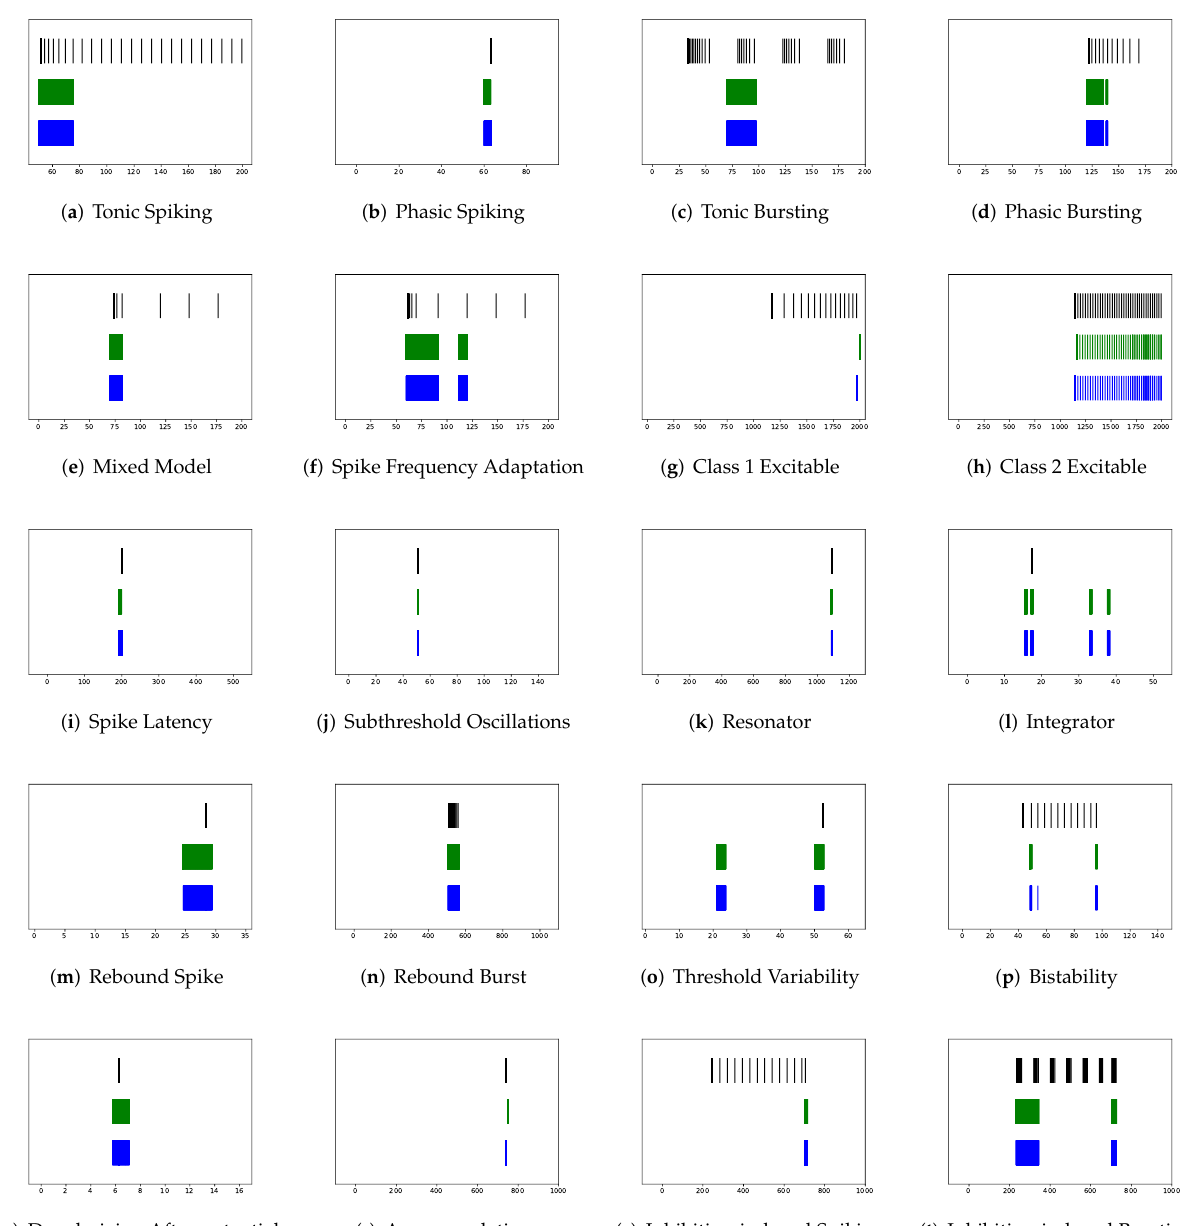
Figure 8. Spike trains of Izhikevich model (black) vs. unmodified RSRM (green) vs. modified RSRM by maximum tolerance (blue), where x-axis is the time (ms). Moreover, Table 2 illustrates that, among all neuron models, RSSRM takes the lowest memory consumption during inference, whereas the Izhikevich model shows the highest memory usage for twenty spiking patterns, excluding (k) resonator, (m) rebound spike, (o) threshold variability and (q) depolarizing after-potential. Compared to SRM, SSRM requires smaller memory for twenty firing behaviors despite a slower inference time. Specif- ically, the memory consumption of SSRM is lower for fifteen firing behaviors (b) phasic spiking, (c) tonic bursting, (e) mixed mode, (f) spike frequency adaptation, (g) class 1 ex- citable, (h) class 2 excitable, (i) spike latency, (k) resonator, (m) rebound spike, (n) rebound burst, (o) threshold variability, (p) bistability, (q) depolarizing after-potential, (r) accommo- dation, and (t) inhibition-induced bursting, while SSRM has only one faster inference time than SRM for (b) phasic spiking. Among neuron models with parameter reduction,